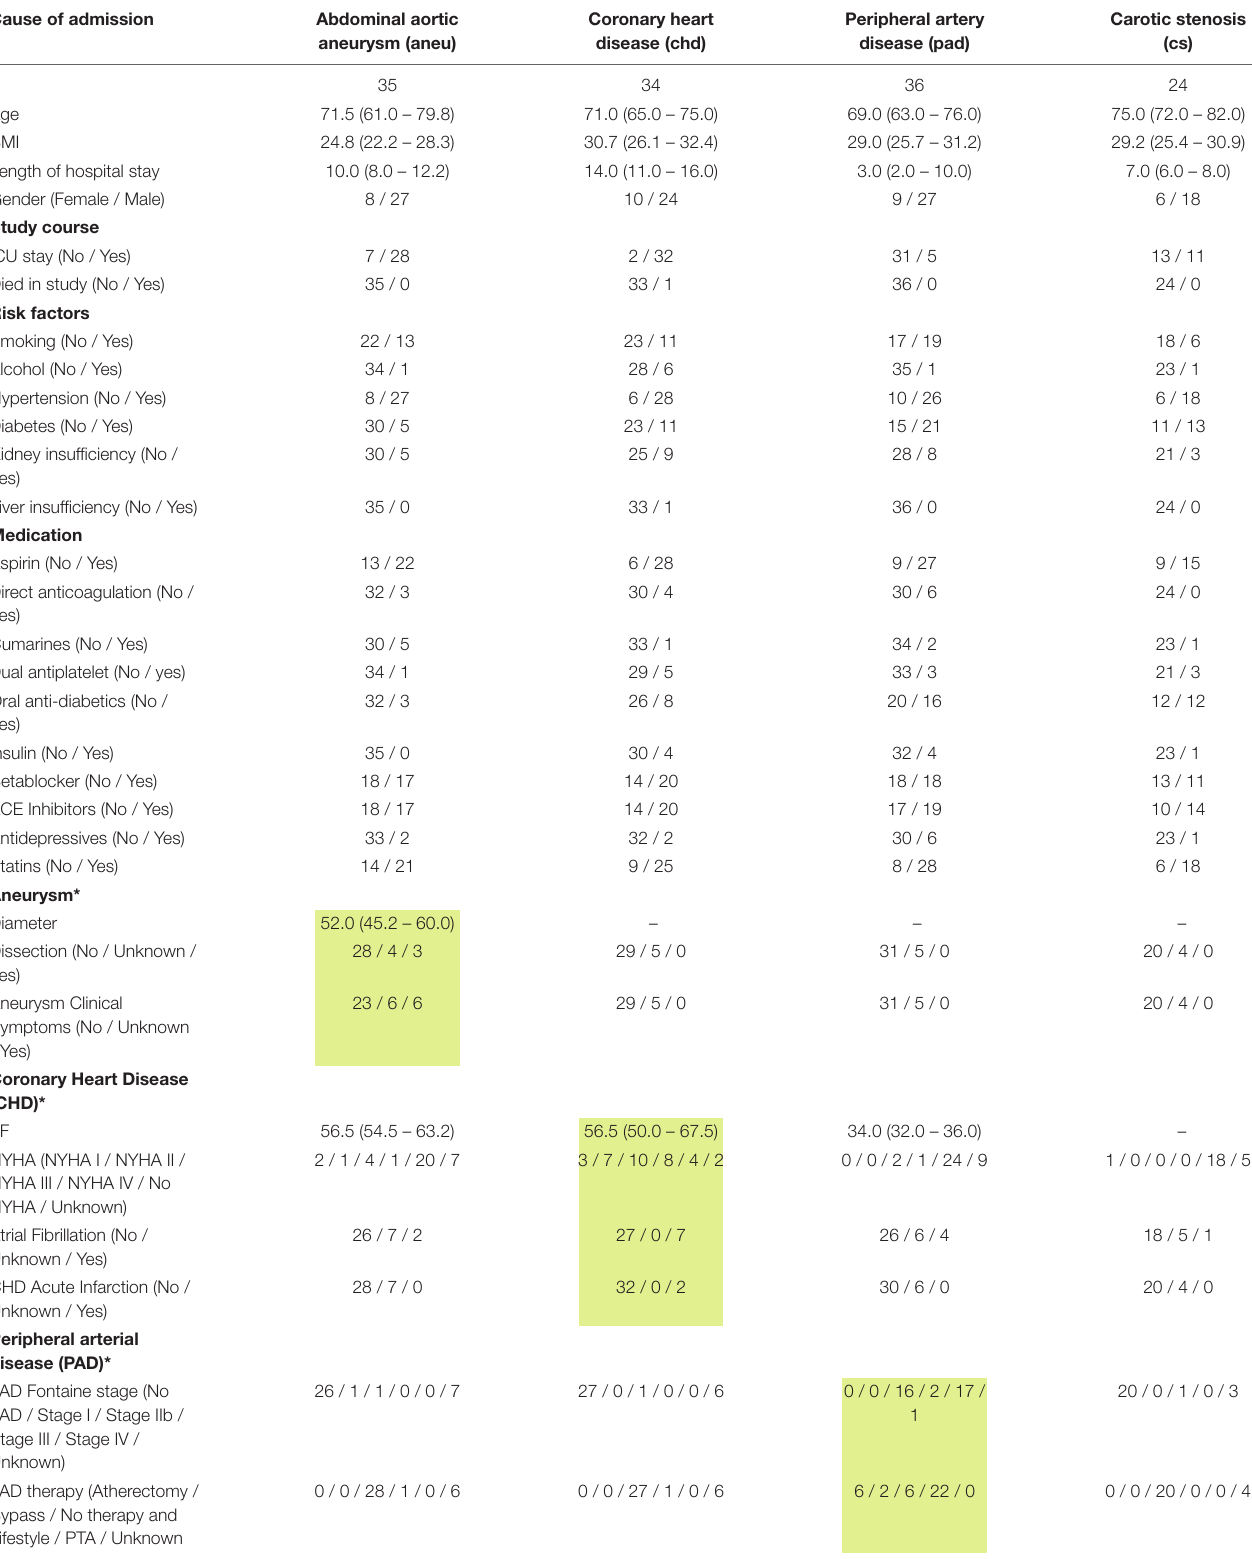
TABLE 3 | Detailed overview of all participating patients of the Arteriosclerosis cohort. Cause of admission Abdominal aortic